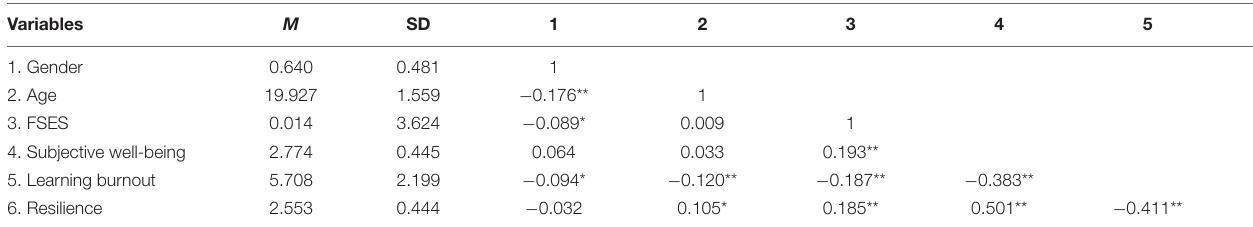
TABLE 2 | Descriptive statistics and correlations for primary study variables ( r , n = 550).